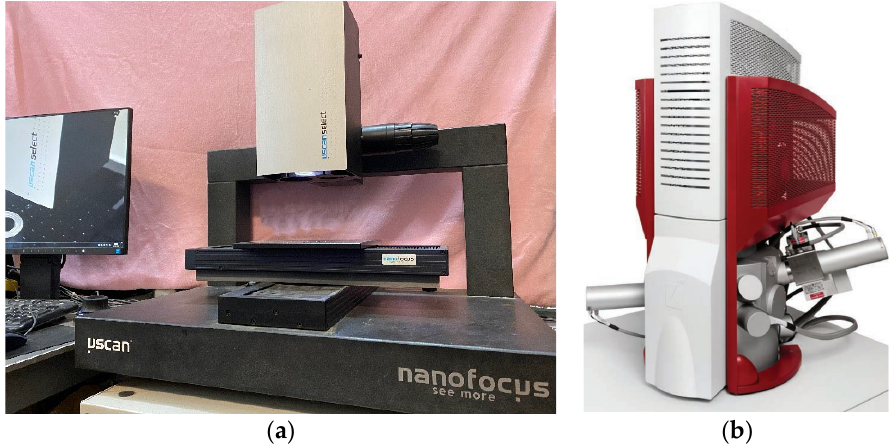
Figure 3. Fracture morphology characterization scanning equipment: ( a ) NanoFocus confocal laser microscope; ( b ) MIRA3 high-performance field emission scanning electron microscope.